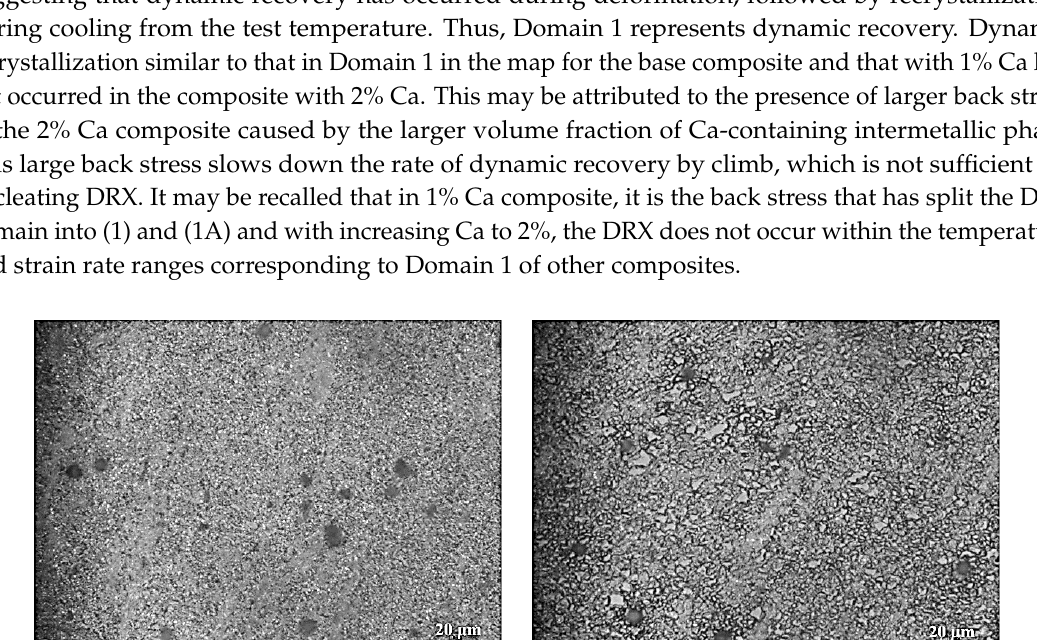
Figure 6. Microstructures of AZ31-2Ca-1.5NAl composite deformed at ( a ) 250 C/0.1 s − 1 (Domain 1) and ( b ) 350 C/0.1 s − 1 (bifurcation region).